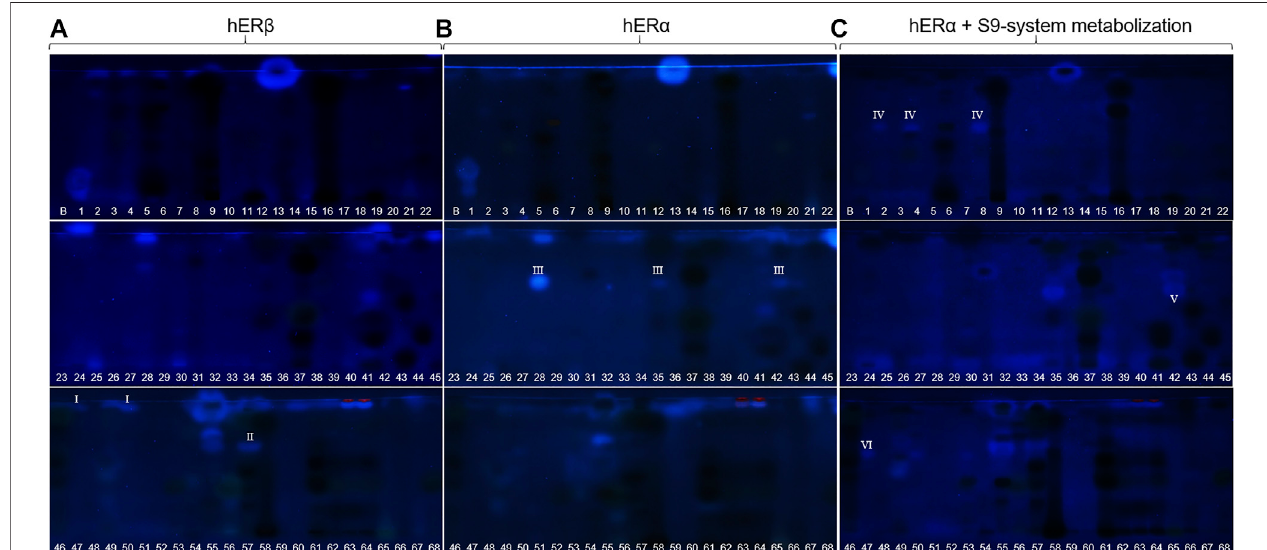
FIGURE5| Comparison and observed differences(I − VI) oftheestrogenicactivity viaNP-HPTLC – pYES using thehER α versushER β used forthe fi rst time,or after metabolization with the S9 mixture. Separation of the applied botanicals (no. 1 – 68, 4 µl/band, assignments in Table 1 ; solvent blank B for comparison) on HPTLC plate silicagel60F 254 MS-gradewithethylacetate — toluene — formicacid — water(16:4:3:2, V/V/V/V )upto70 mm,detectedatFLD366 nmafterpYES.Cellswereequipped either with hER β (A) , hER α (B) or phytochemicals were metabolized with the S9 enzyme mixture, simulating liver metabolism (C) .